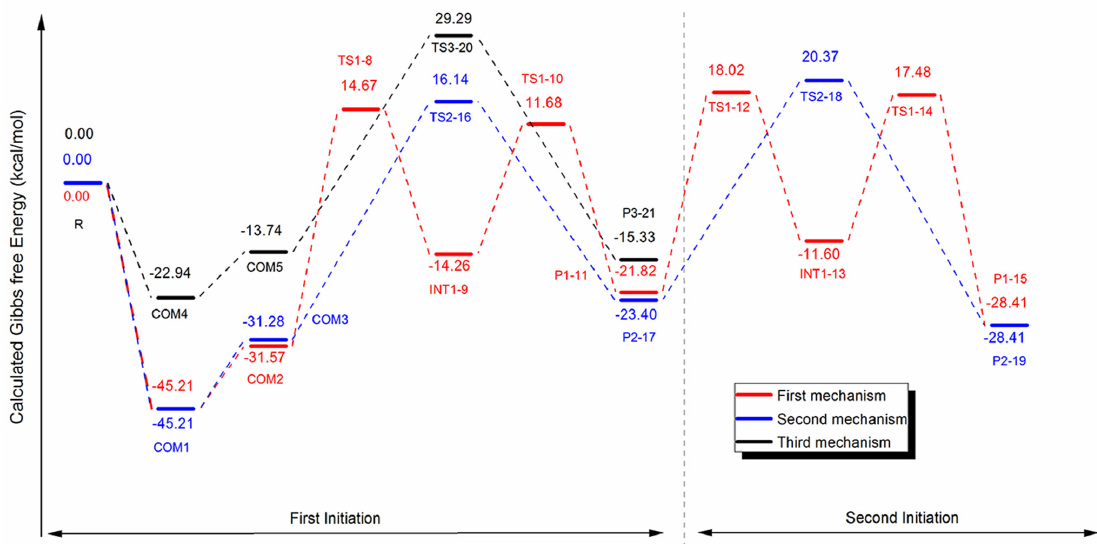
Figure 5. Calculated Gibbs free energy profiles for three ROP mechanism pathways of CL initiated by 2a and 1-butanol calculated at B3LYP/6–31G(d,p) level.